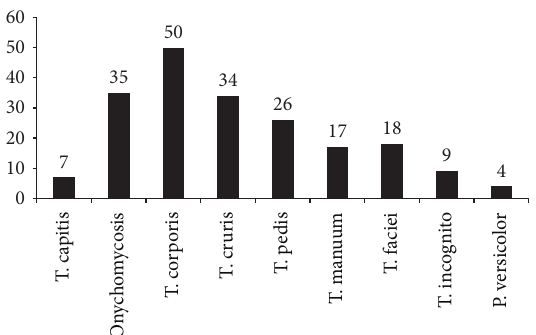
Figure 1: Distribution of various clinical types ( 𝑁 = 200 ).